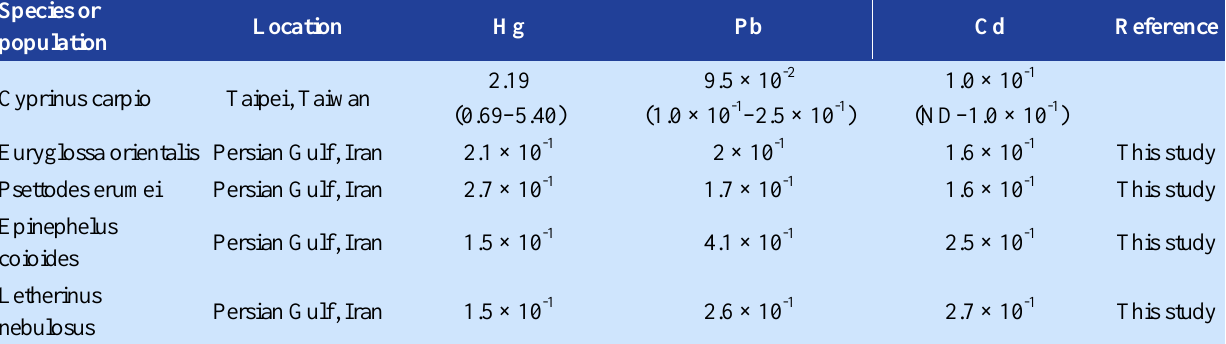
Table 4. Heavy metal concentrations (µg.g-1 dry weight) in fish in other water areas (Continue) Species or